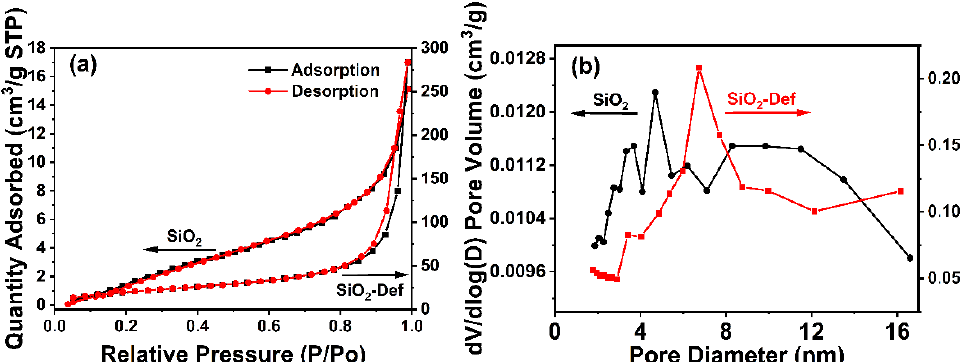
Table 2. Specific surface areas, pore volumes, and pore diameters of SiO 2 and SiO 2 -Def. Sample